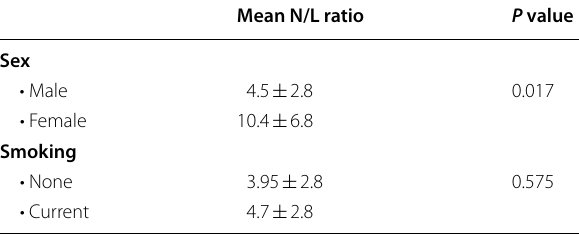
Table 4 Relation between Mean N/L ratio and sex and smoking